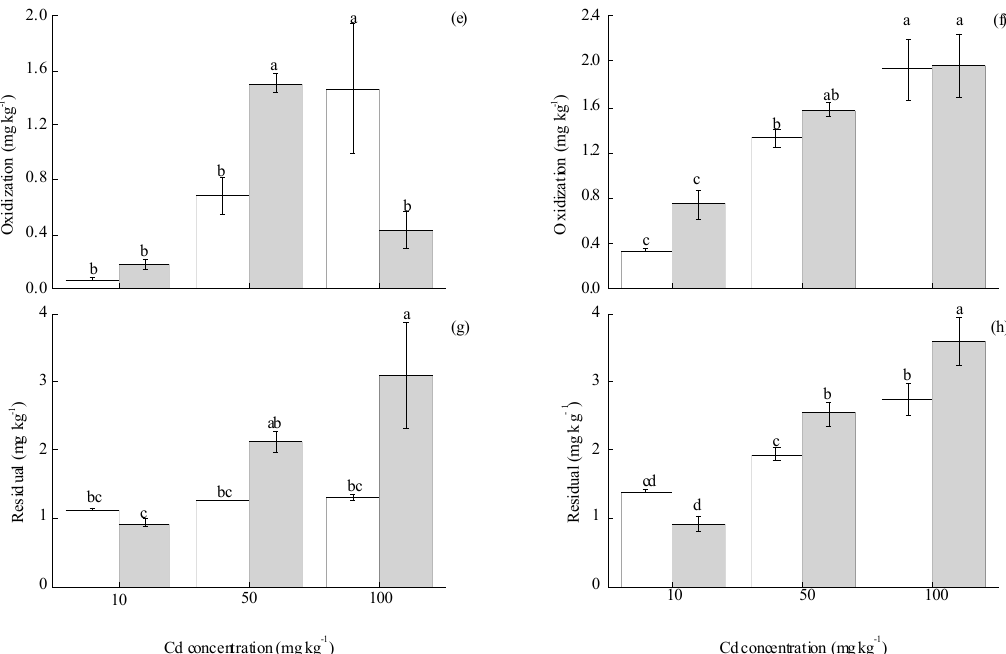
Figure 4. Effect of Si on the fractions of Cd in soil for ( a , c , e , g ) P. glaucum × P. purpureum and ( b , d , f , h ) P. glaucum . ( a , b ) Exchangeable Cd. ( c , d ) Reducible Cd. ( e , f ) Oxidizable Cd. ( g , h ) Residual Cd. Values followed by the different letters indicate significant differences between the different treatments of the same variety, according to one-way ANOVA followed by the Duncan test ( p < 0.05).